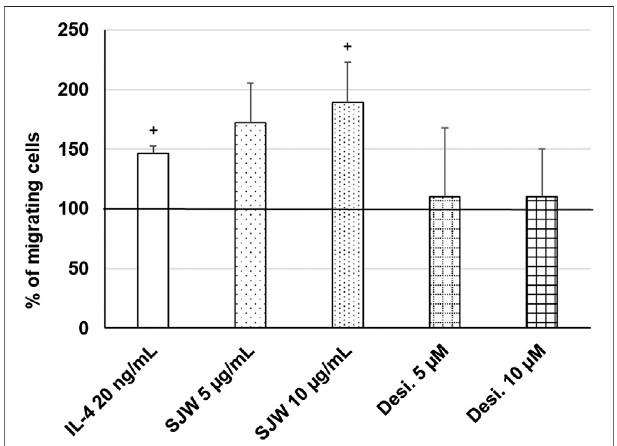
FIGURE 8 | Effects of 24 h treatment with STW3-VI [St. John ’ s wort (SJW)],desipramine (desi.), orIL-4aspositivecontrolonmigratorycapacityof mouseSIM-A9microglia.Quanti fi cationofmigratedcells/cm 2 in%ofnegative control (100%) expressed as mean + SEM; signi fi cance (by T-TEST): + p ≤ 0.05 vs. untreated control; n (cid:2) 3 ‒ 5 independent experiments.